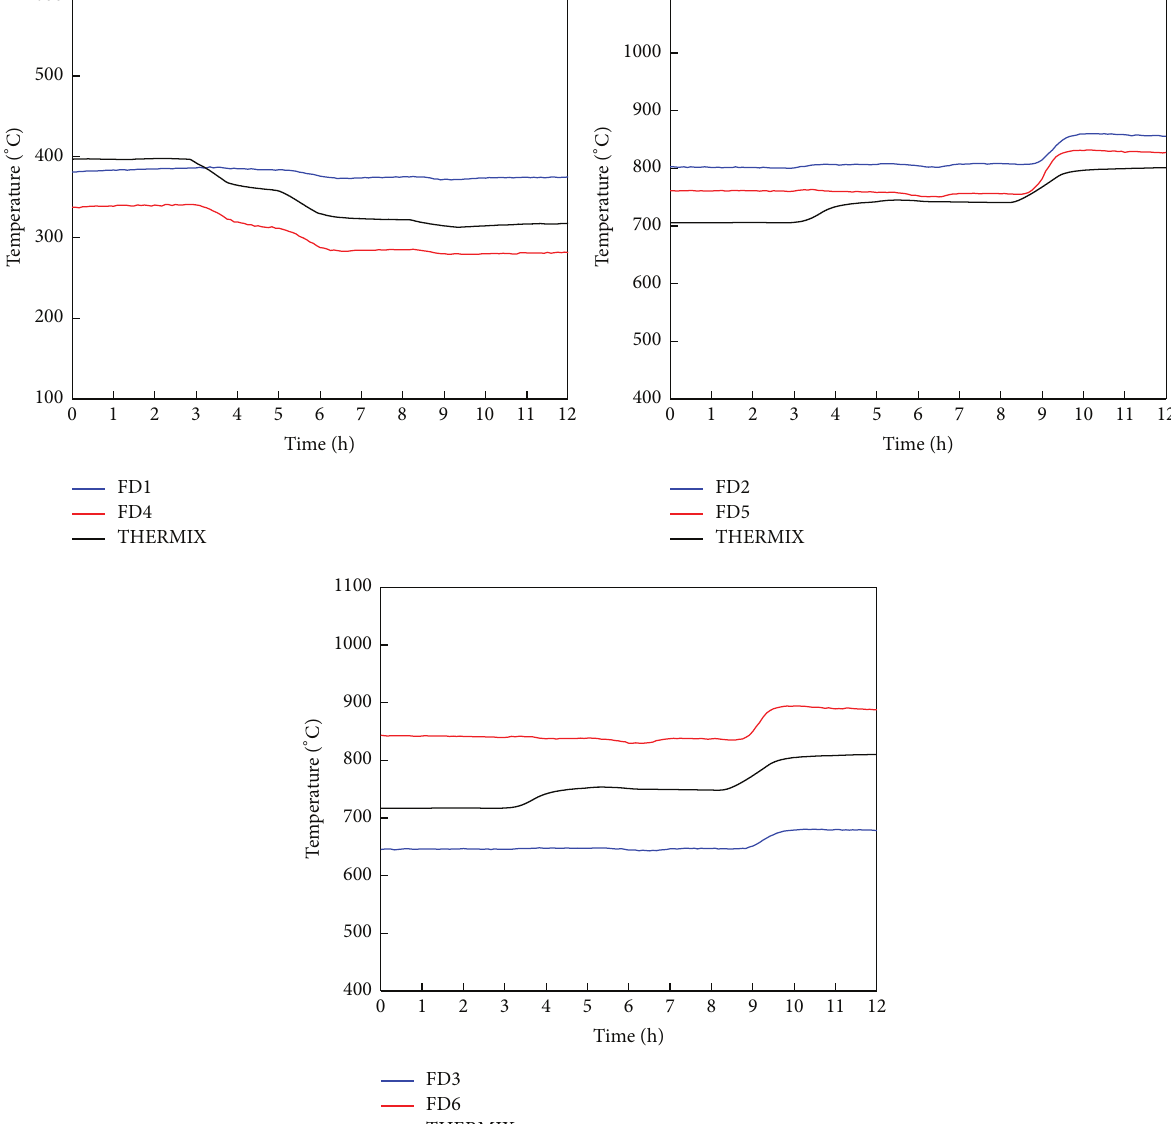
Figure 15: Temperature transient of the fuel discharging